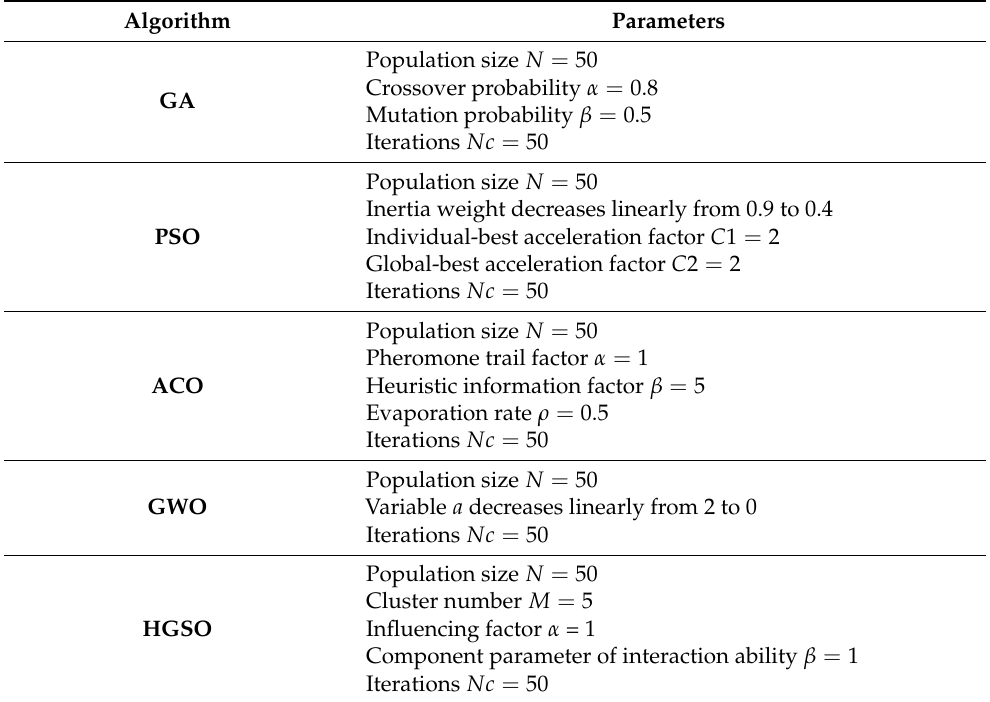
Table 2. The Parameter settings of